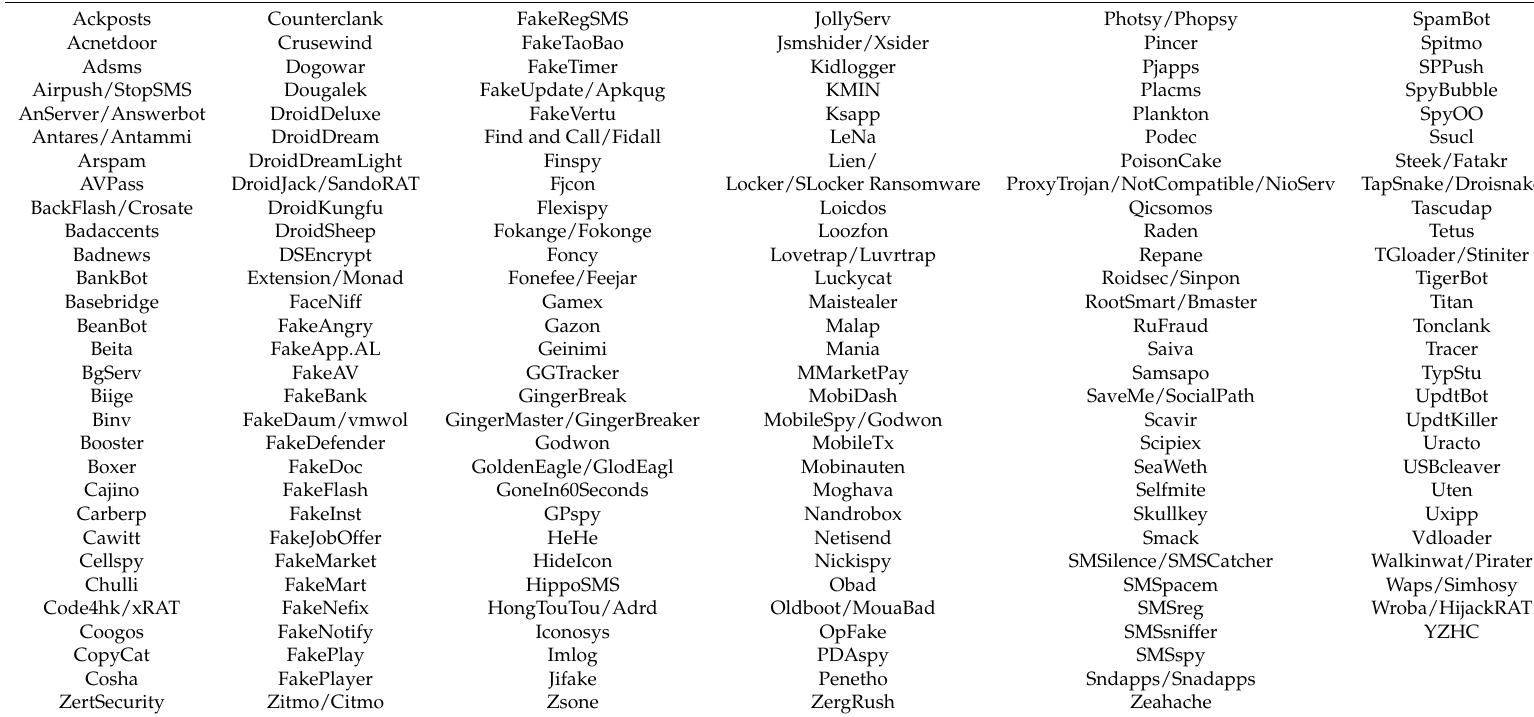
Table 2. Common Android malware